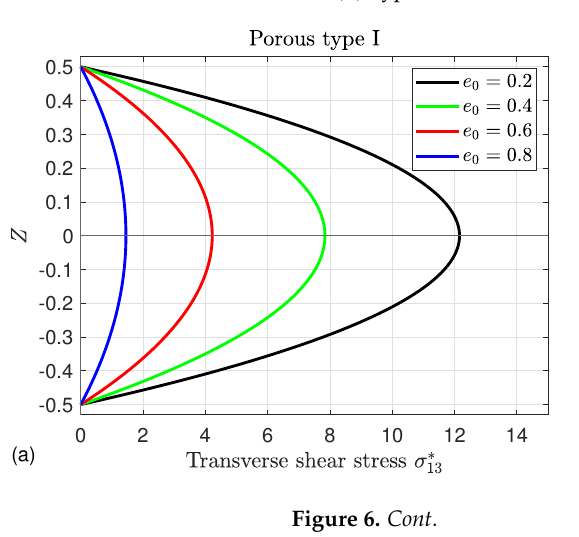
Figure 5. Influence of the porosity factor e 0 on the normal stress σ ∗ piezoelectric square plates for different porosity distribution types: ( a ) Type I, ( b ) Type II, ( c ) Type III and ( d ) Type IV.